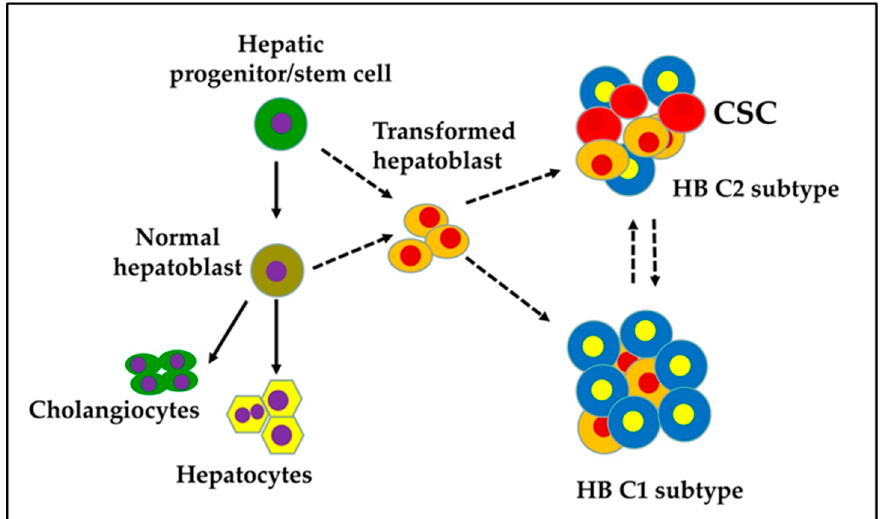
Figure 1. Proposed cellular origin of cancer stem cells (CSC) in a hepatoblastoma